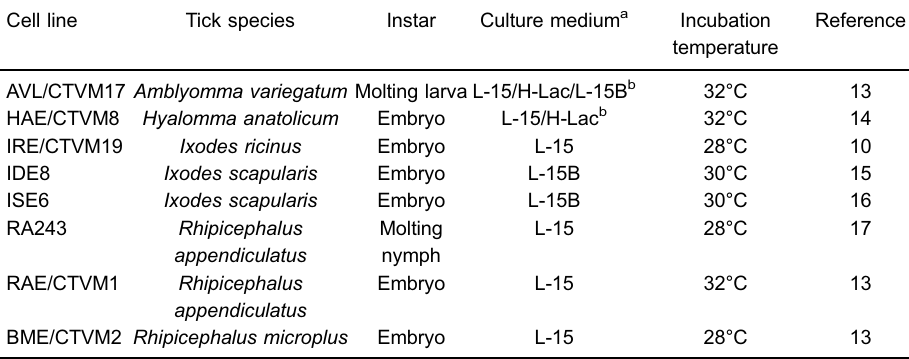
Table 1 . Tick cell lines inoculated with Borrelia burgdorferi . Tick species, instar, culture medium, incubation temperature and original reference are indicated for each cell